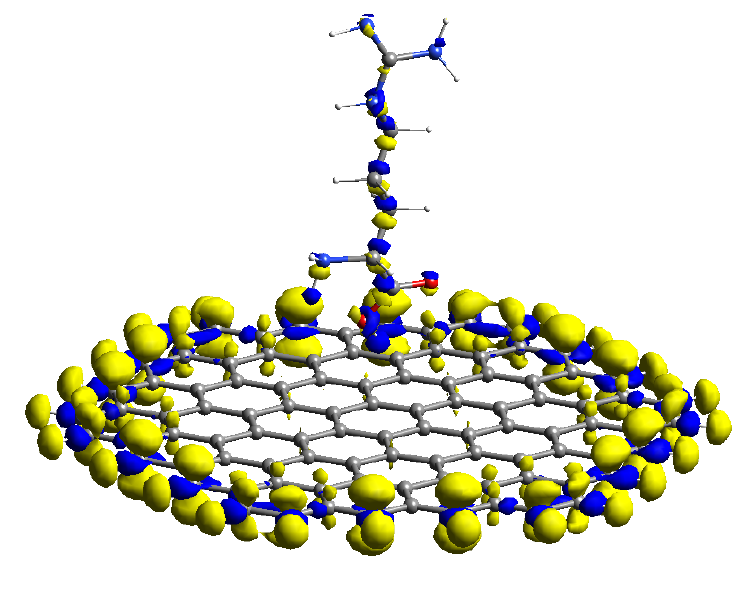
Figure 5. f o ( r ) (ISO = 0.04).